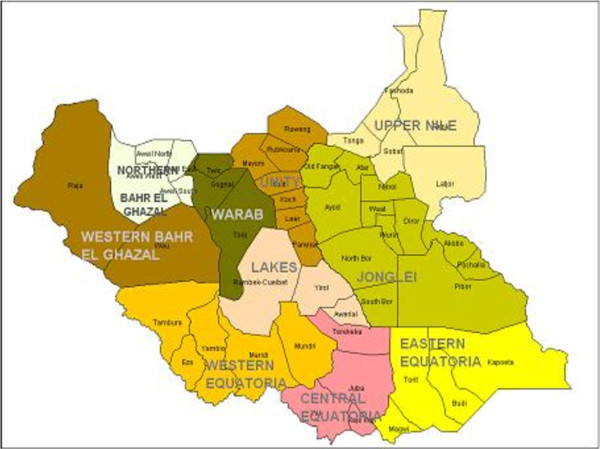
Map of South Sudan.